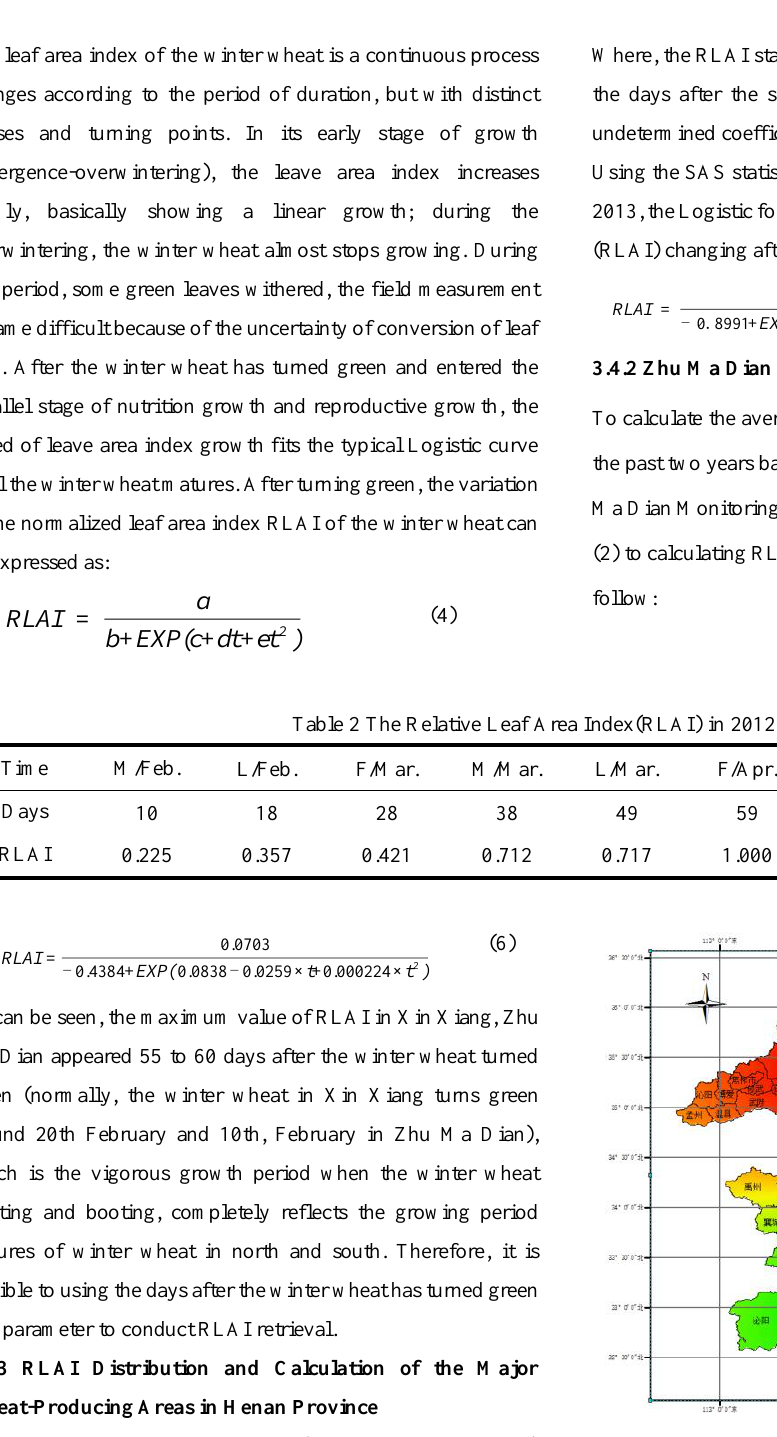
Figure 2 The distribution map of the number of days of leaves turning green where the maximum leaf area index appeared From the distribution map, it can be observed that there is a difference between the south and the north in terms of the number of days of leaves turning green where the maximum value of winter wheat LAI appeared. For the sake of calculation, 34 ° 30' northern latitude is taken as the borderline, the southern Henan Province uses the RLAI of Zhu Ma Dian to